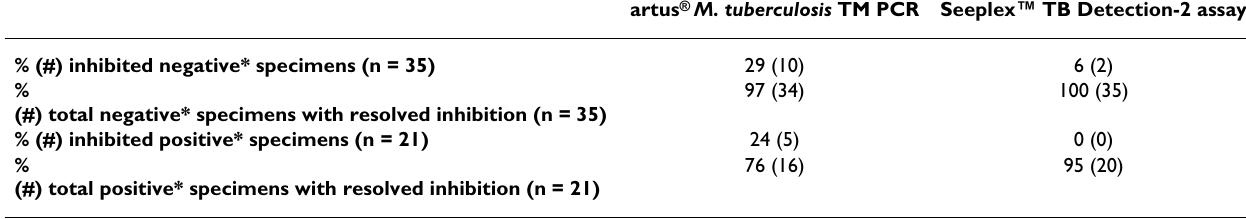
Table 1: Relative test performance of two commercia1 assays for MTB complex detection in formalin-fixed parafinized biopsy specimens.